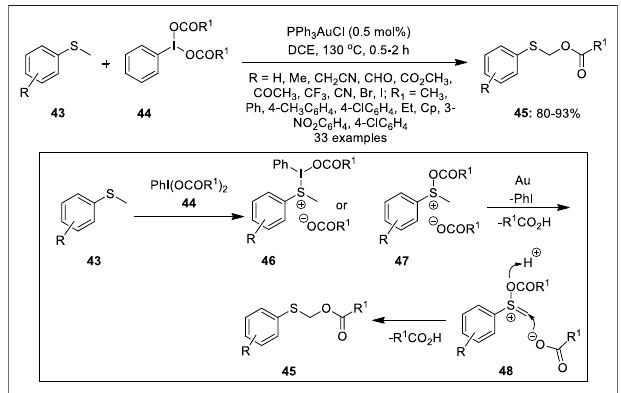
Frontiers in Chemistry |